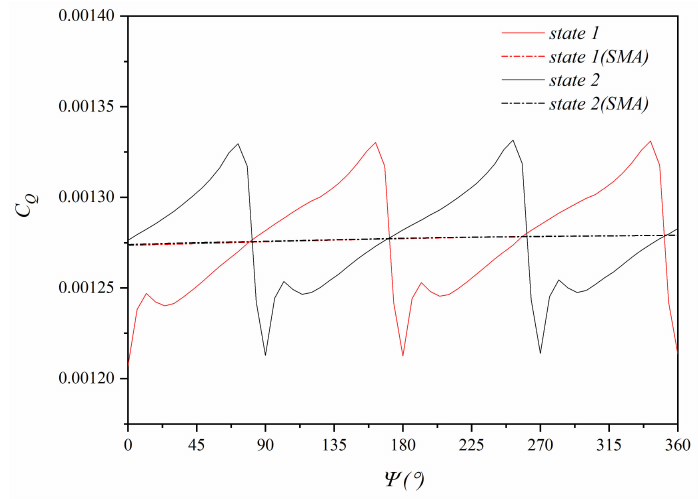
Figure 14. The isolated rotor C Q in